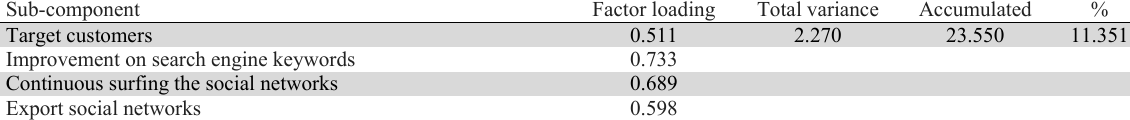
The summary of the sub-component influencing on details of content marketing Sub-component